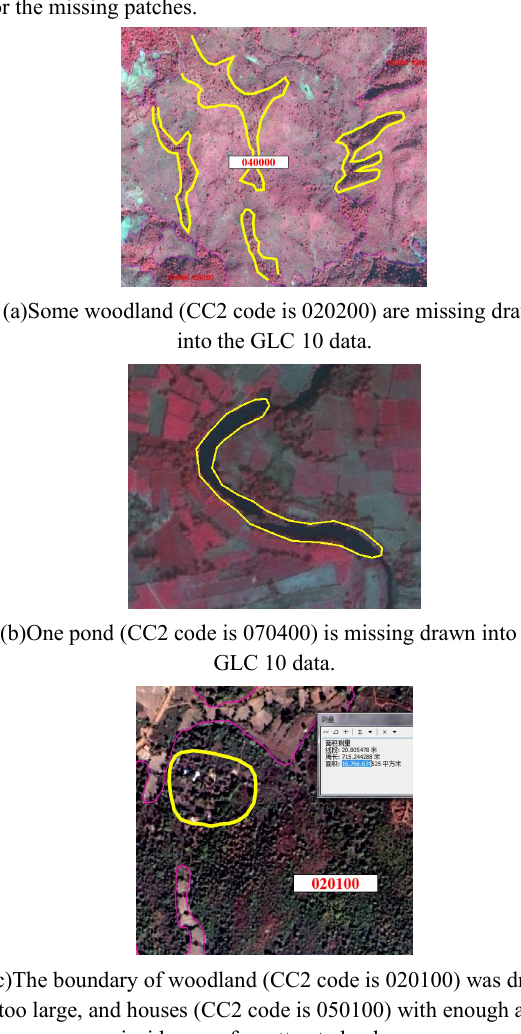
Figure 4 . Land cover patches are missing drawn into the GLC 10